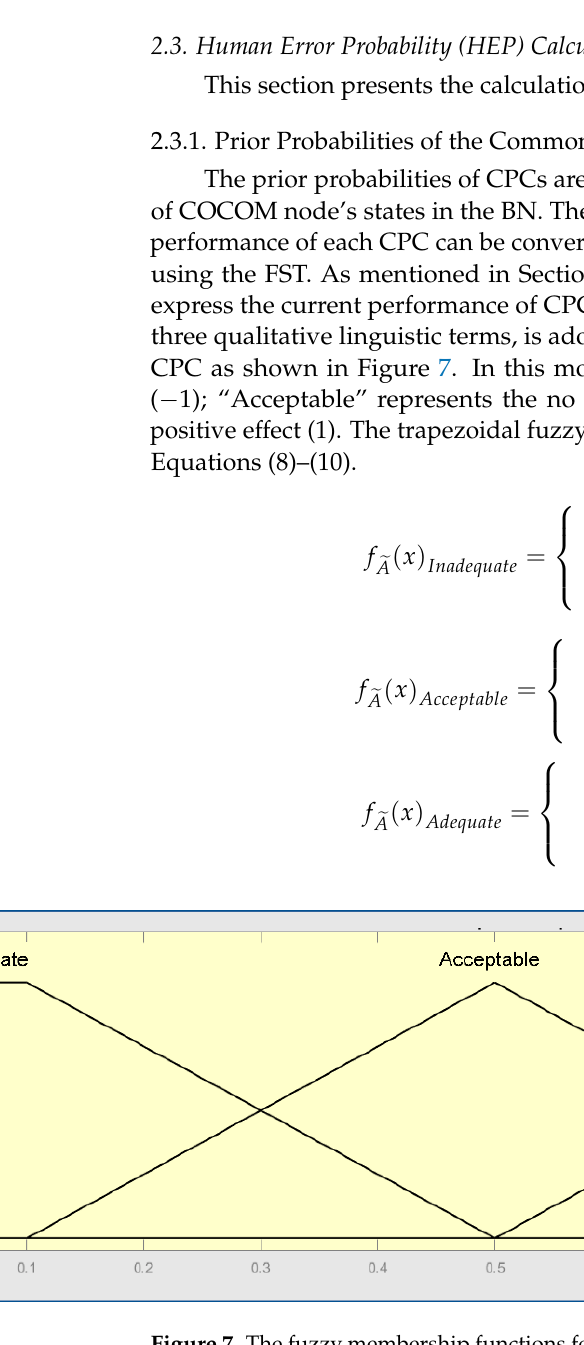
Table 5. A part of the conditional probability table (CPT).